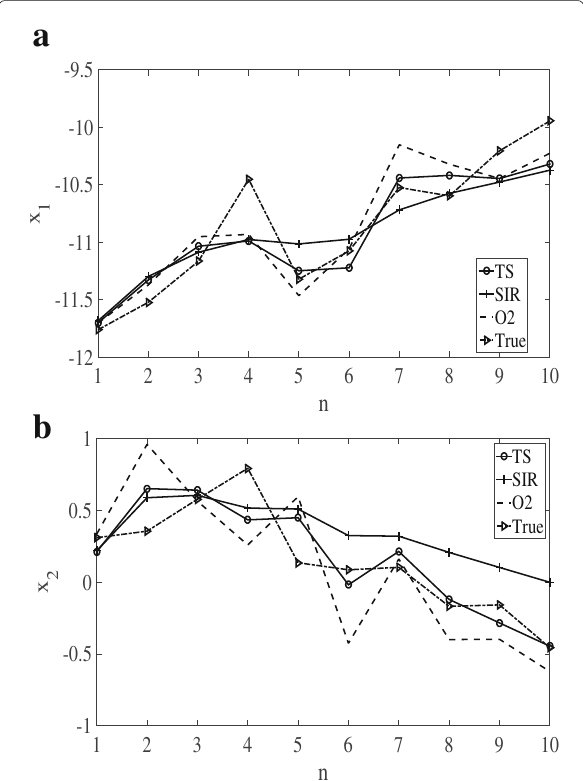
Fig. 2 An illustration of the traceplots of average RMSE over N = 100 experiments for the TS, SIR, and O 2 procedures for R = 0.1 and Q = 0.2: ( a ) x n ,1 and ( b ) x n